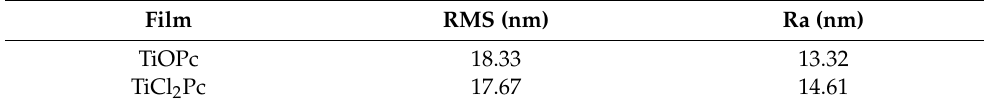
Table 2. Roughness and mechanical properties of the TiOPc and TiCl 2 Pc films.